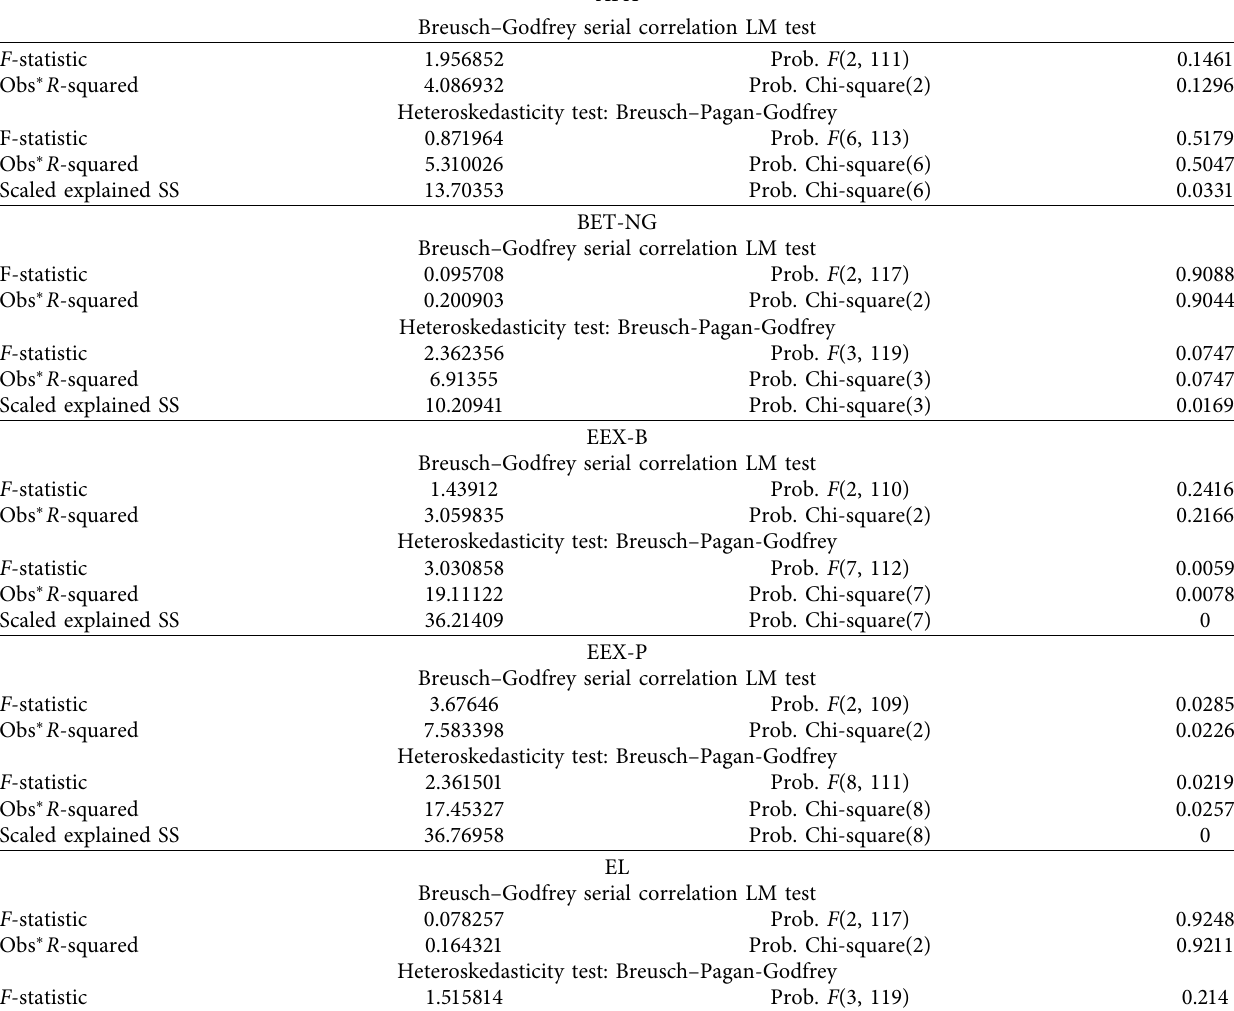
Table 11: ARDL diagnosis